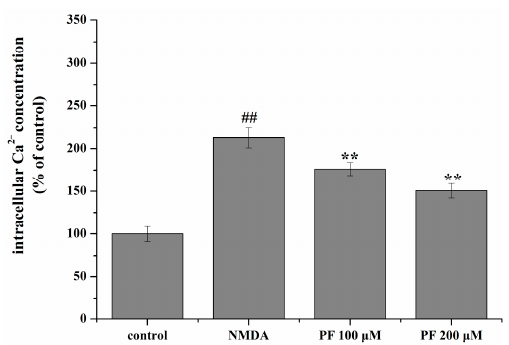
Figure 5. Effect of PF on intracellular Ca 2+ concentration in NMDA-induced PC12 cells. Intracellular